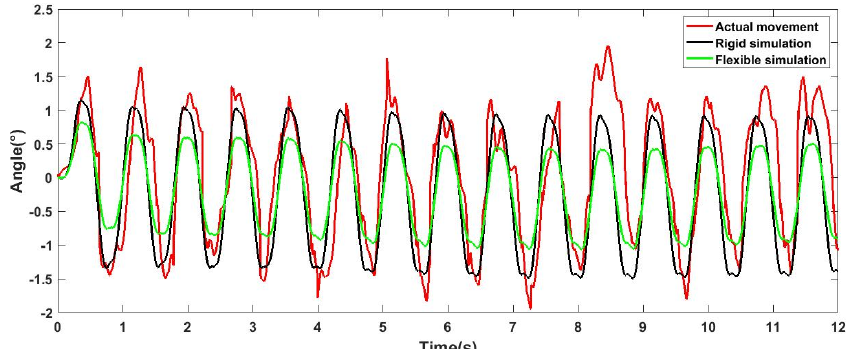
Figure 16. Deviation diagram of robot rolling direction.